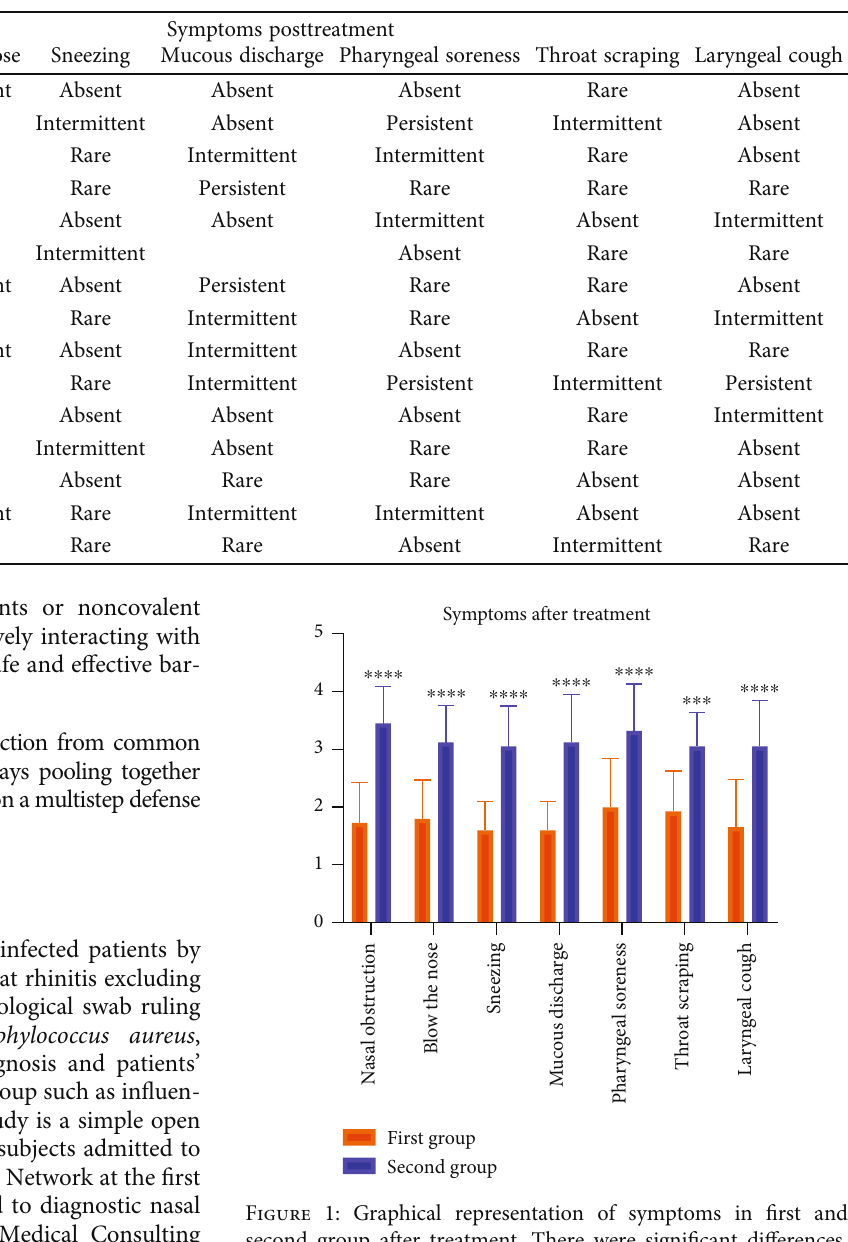
Table 4: Description of symptoms in the fi rst group (our spray) after